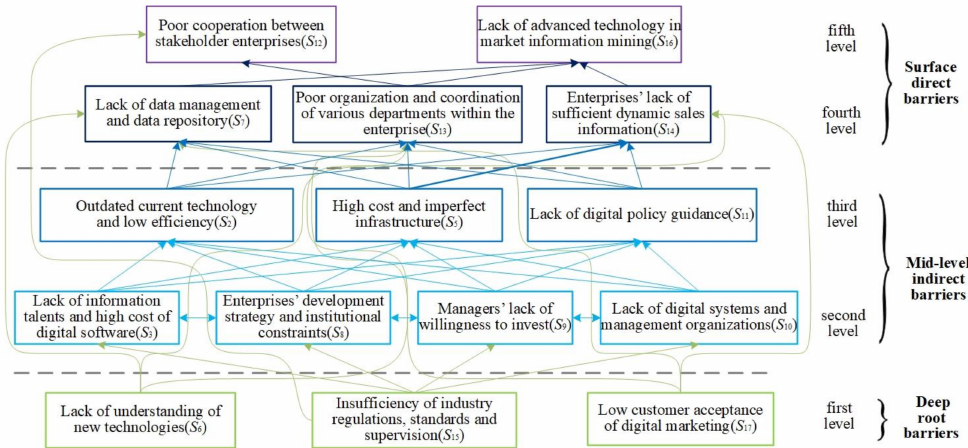
Figure 10. The five-level hierarchical structure model of the influencing factors for the digitalization of operations management in real estate enterprises. Note: The figure was drawn with Microsoft Visio